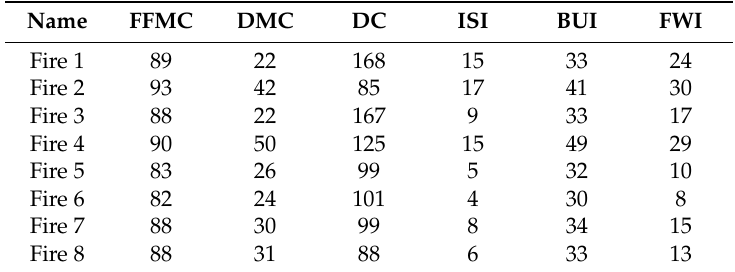
Table B1. Daily FWI System components for each natural fire start point encountered during the interval 1971–2000